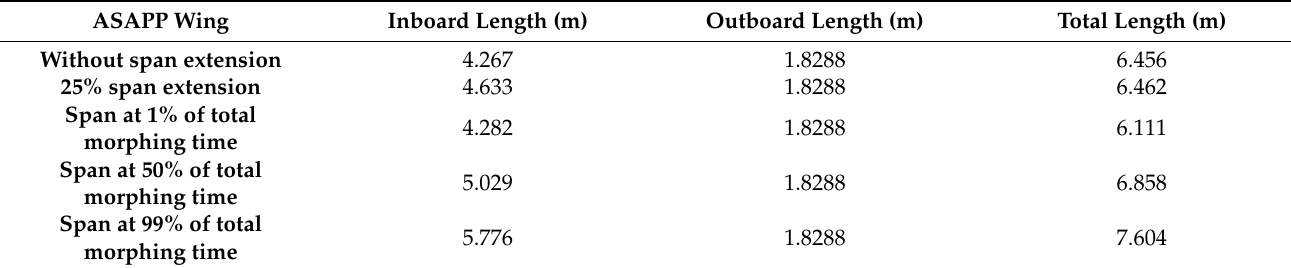
Table 3. Span extension lengths of inboard and outboard wing